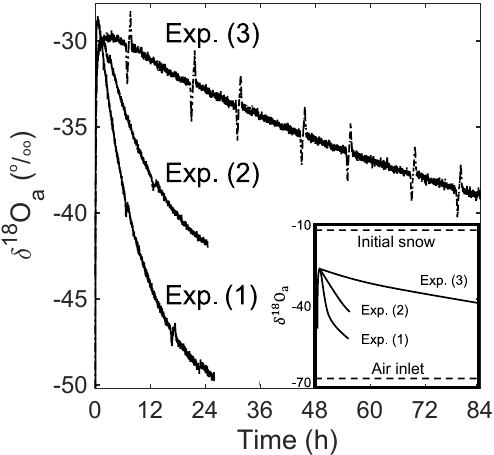
Figure 2. Temporal isotopic composition of δ 18 O of the outflow for each of the experimental runs. The spikes in the δ 18 O were due to small temperature changes in the cold laboratory (Ebner et al., 2014). Exp. (1) corresponds to the isothermal conditions, Exp. (2) to air warming and Exp. (3) to air cooling in the snow sample. The higher the recrystallization rate of the snow the slower the adaption of δ 18 O of the outlet air to the inlet air. The illustration in the lower right corner shows the relation between δ 18 O of the initial snow, inlet and outlet of the air.